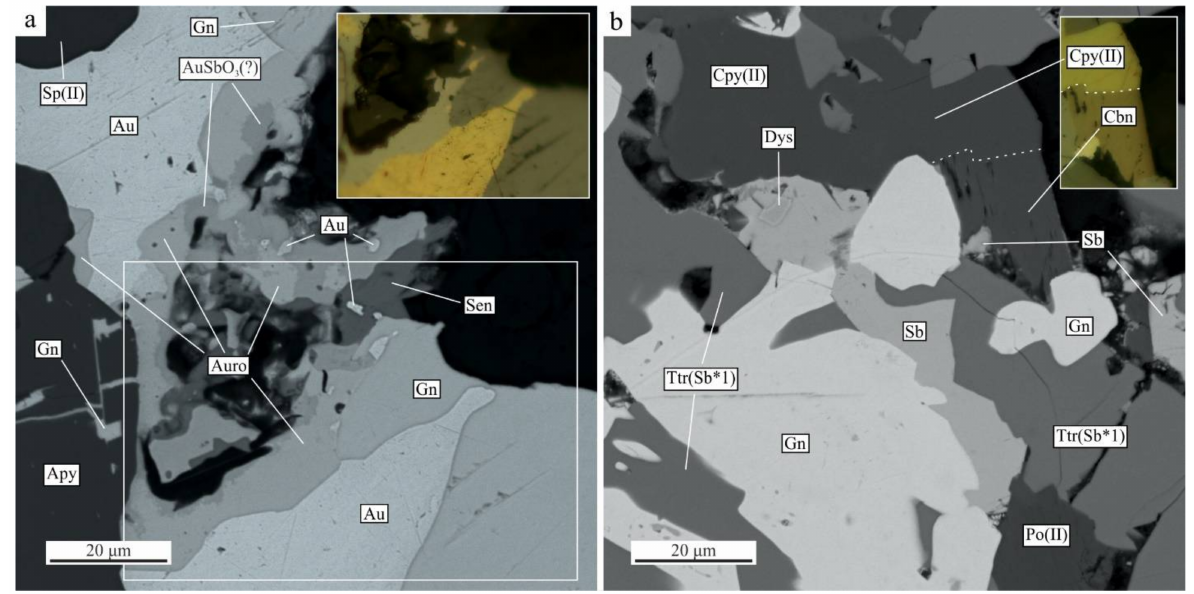
Figure 15. Backscattered electron micrographs showing relationships between late antimony minerals and minerals of the polymetallic association at the Kultuma deposit. ( a ) Native gold grains were partially replaced by aurostibite; ( b ) early galena, chalcopyrite, tetrahedrite, pyrrhotite, cubanite and late native antimony micro veinlet. Abbreviations: Sb*—Sb/(Sb + As);